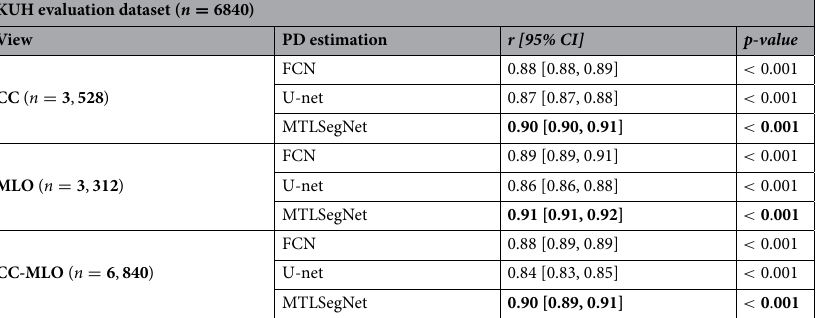
Table 6. The Pearson correlation between the estimated PD values and radiologist-provided PD values at 95% confidence interval. For all three CC-, MLO-, and CC-MLO-view mammograms, MTLSegNet shows a higher correlation than the baseline models. Before correlation analysis, we applied a log transform to all density values. We highlighted the model with strongest correlation with the radiologist PD values. Best values are in